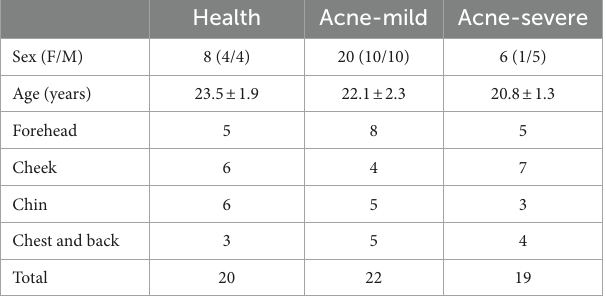
TABLE 1 The basic information of subjects and